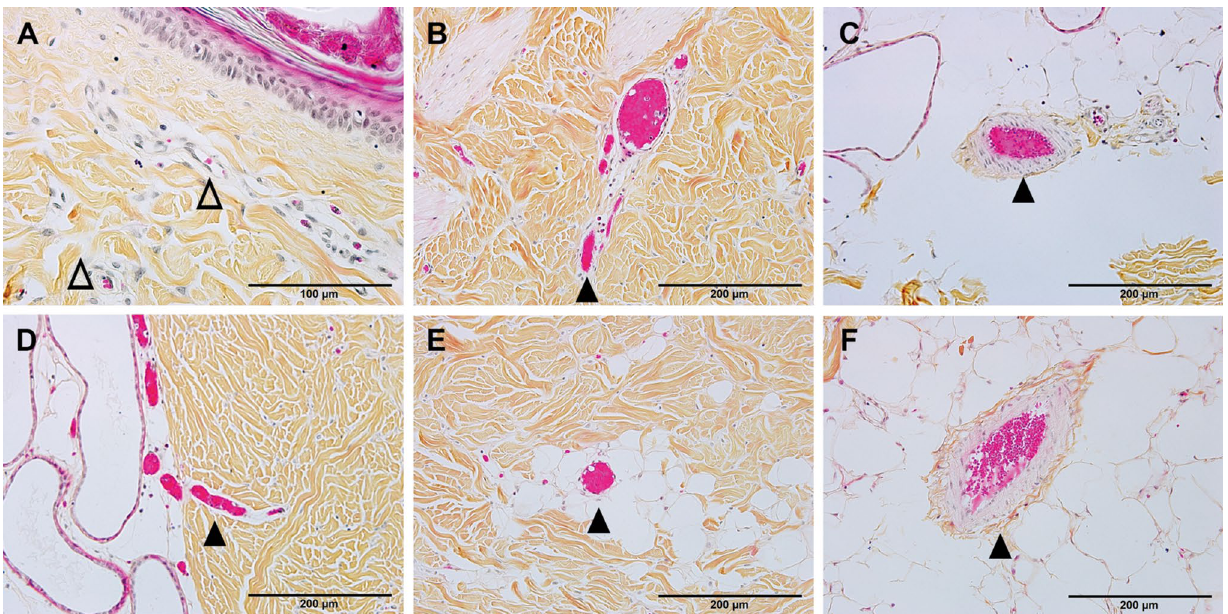
Figure 3. A , B , C , D , E , and F are high-power images of the boxes outlined in the corresponding micrographs in Fig. 2. These photomicrographs are taken from the burn site of porcine burn wounds harvested at 0, 0.5, 1, 2, 4, and 24 h, respectively. ∆, patent vessels beneath the epidermis of control. ▲ , blocked blood vessels. Bar = 200 µm ( B to F ), 100 µm ( A